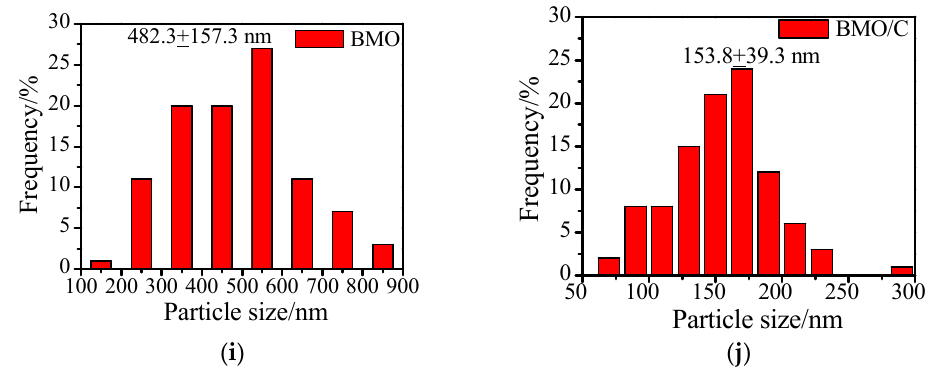
Figure 4. ( a , c ) low and high magnification SEM images of BMO; ( b , d ) low and high magnification SEM images of BMO/C; ( e , f ) composite false-color STEM images of the BMO and BMO/C samples, with the Z-contrast image superimposed on the Secondary electron background image; bright colors signify high Z material (The images have been colorized by assigning the grey scale intensity range to a colour tone range using ImageJ and its look-up-tables Blue-Orange and Thallium for the Z-contrast and the secondary electron image, respectively); ( g , h ) statistically calculated long/ short axes ratio of the BMO particles in the BMO and BMO/C samples; ( i ,j) statistically calculated BMO particle size in the BMO and BMO/C samples.